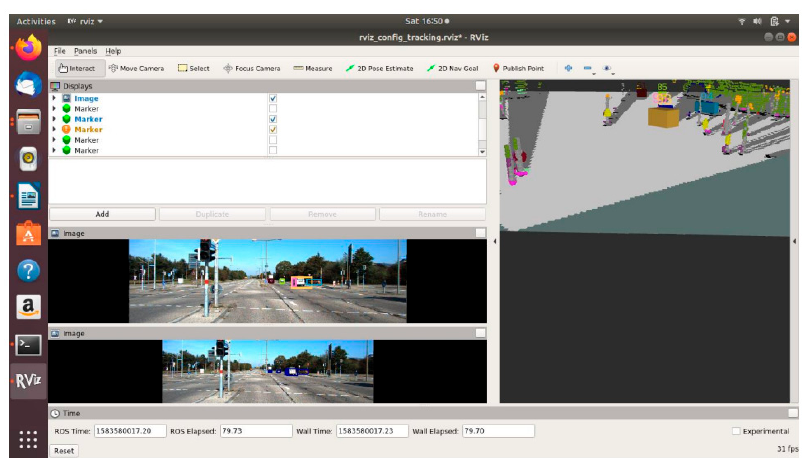
Figure 13. Output of sensor fusion in brightly lit surroundings.